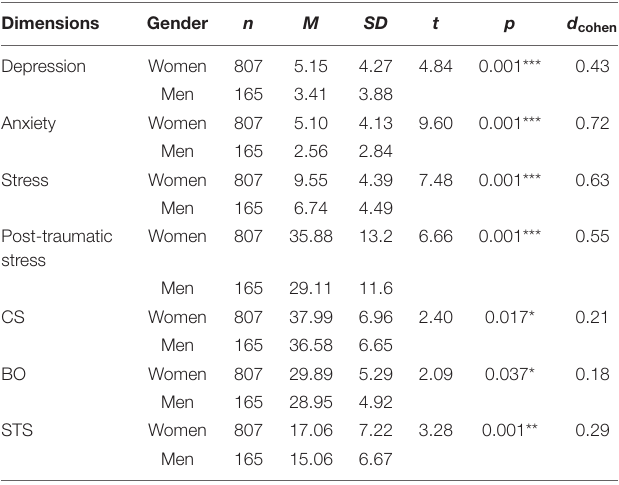
TABLE 3 | Differences in the means of the variables according to the gender of the participants.